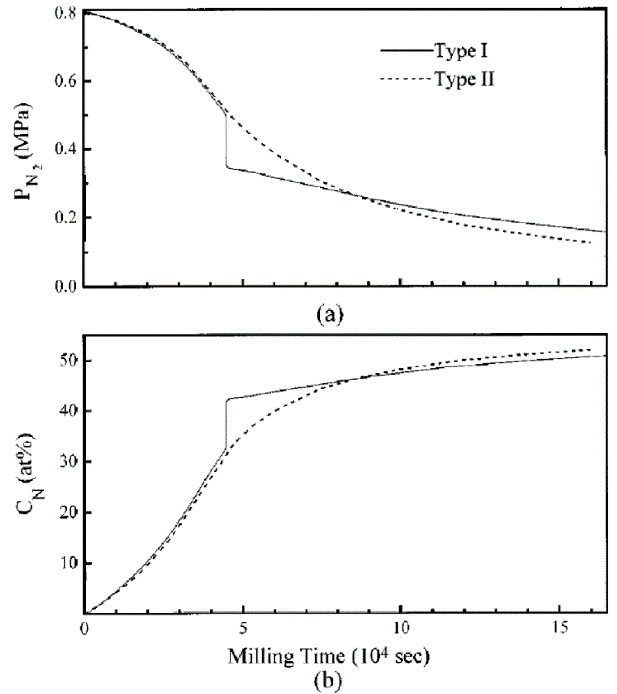
Figure 4. The difference between continuous formation and mechanically initiated self-combustion reaction (MSR) in the synthesis of TiN from the elements, illustrated by measuring: ( a ) the drop in nitrogen gas pressure during milling and ( b ) the change in nitrogen concentration within the milled solid sample [81] .